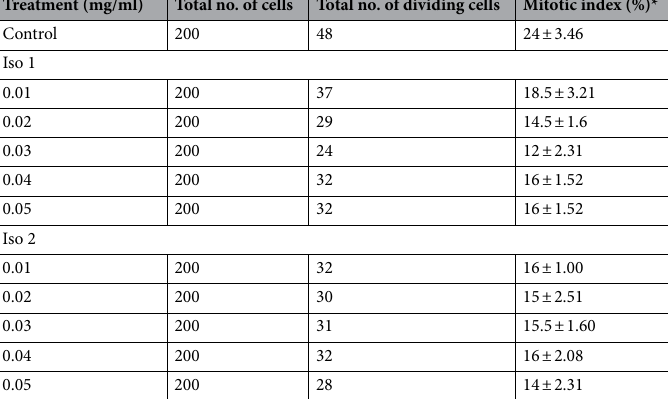
Table 5. Mitotic index of isolated colchicine (Iso 1) and gloriosine (Iso 2) at 24 h after treatment. *Mean value (n = 3) ± standard error.